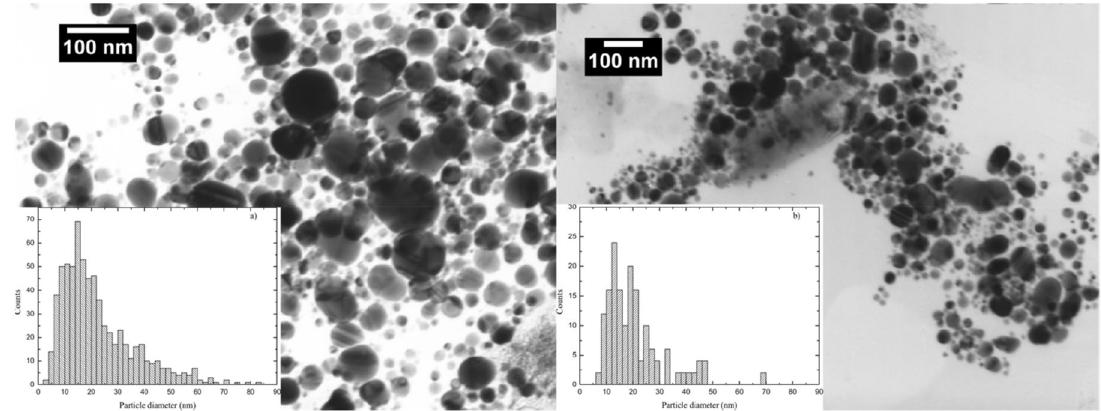
Figure 5. SEM—images and size distribution of silver nanoparticles in water (left) and in TSC